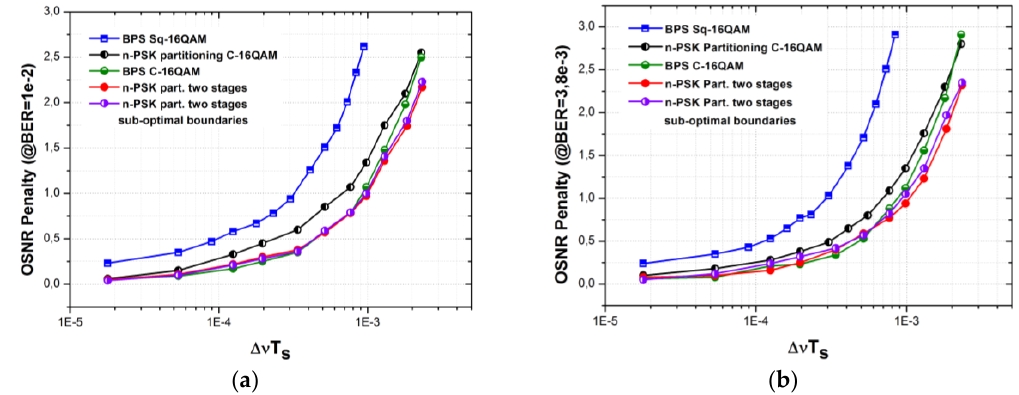
Figure 3. Optical signal-to-noise ratio (OSNR) sensitivity penalty versus Δ νT s for C-16QAM and Sq-16QAM utilizing different CPR schemes at a BER of 1 × 10 −2 ( a ) and 3.8 × 10 −3 ( b ).